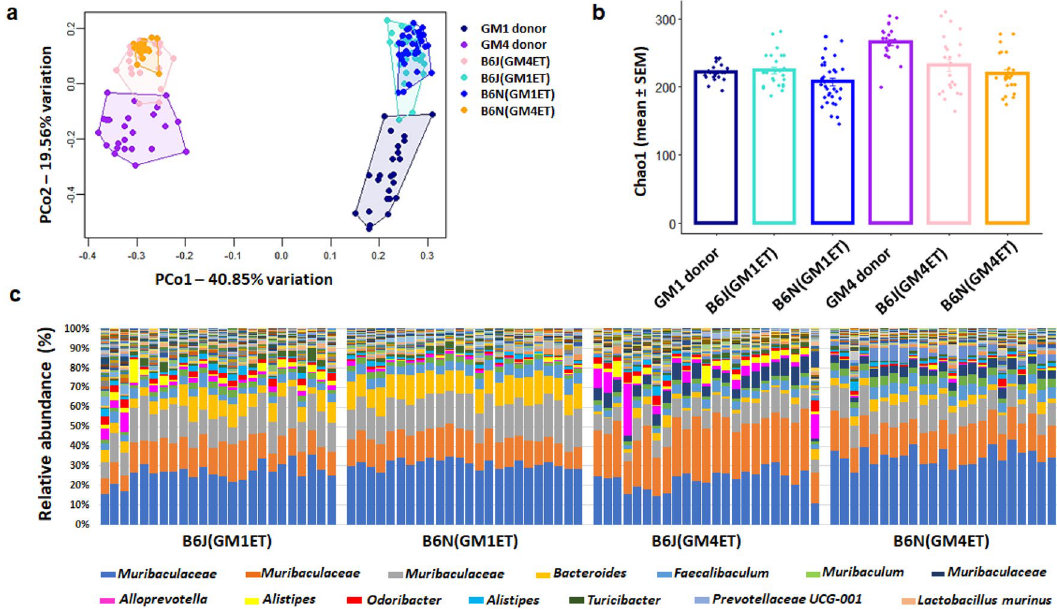
Figure 2. Donor GM (primary) and recipient genetics (secondary) sources of GM variability in embryo transfer derived recipient mice . (a) Principal Coordinate Analysis plot of OTUs from fecal samples of 7-week- old embryo transfer (ET) derived B6J and B6N mice colonized with GM1 or GM4. (GM1 vs. GM4: p = 0.001, F = 189.17; B6J vs. B6N: p = 0.001, F = 44.65, Bray–Curtis.). ( b) Chao-1 index of 7-week-old mice generated using the ET method revealed main effects: B6J vs. B6N p = 6.29e-06, F = 13.00; GM1 vs. GM4: p = 4.07e-06, F = 22.91 as well as an interaction between recipient genotype and GM p = 0.0049, F = 5.51; ANOVA followed by Bonferroni adjustment for 4 pairs group comparison. ( c) Bar chart showing differing relative abundance of all taxa detected in substrains B6J and B6N that received GM4 and